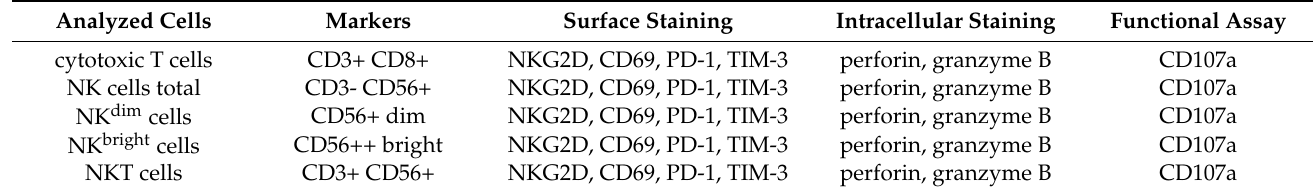
Table 2. Flow cytometric staining of the analyzed